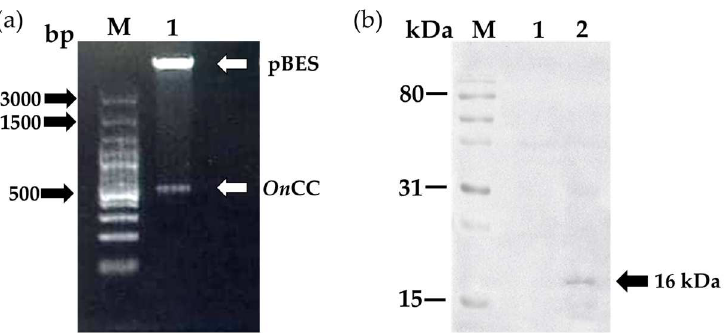
Figure 6. Restriction enzymes ( Bam HI, Hind III) digestion ( a ) Western blot analysis of pBES On -CC ( b ); lane M: protein marker, 1: Bacillus isolate B29 (Negative control), 2: pBES On -CC.